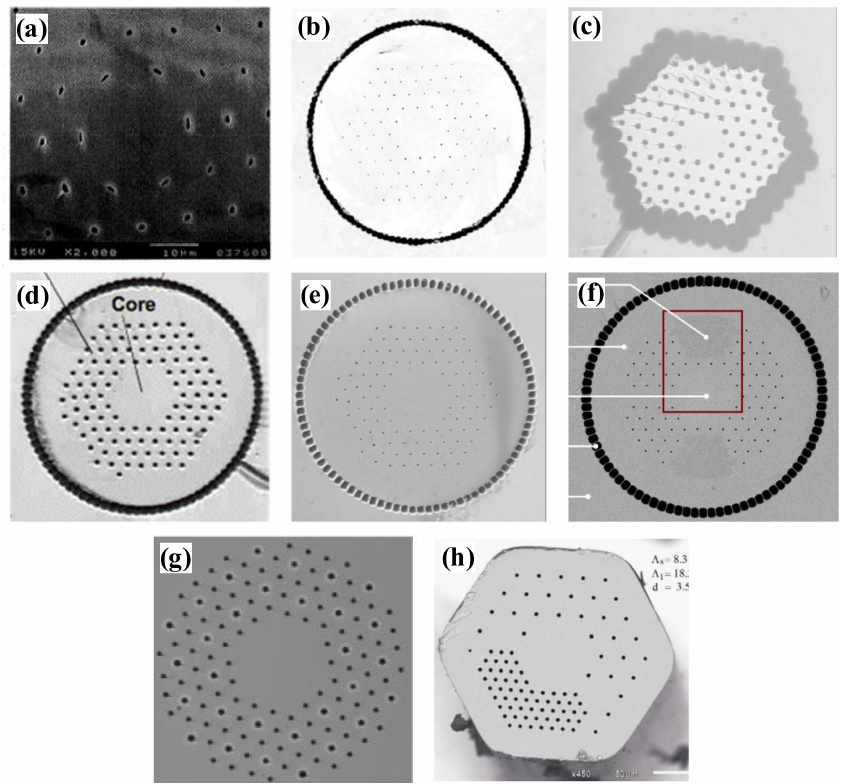
Figure 5. Schematic structure of LMA-PCFs ( a ) 22.5 µ m core diameter developed at Bath Univer- sity [51]; ( b ) 35 µ m mode field diameter rod PCF designed at Jena University [55]; ( c ) Yb-doped PCF with a mode field diameter of 30 µ m developed at Jena University [54]; ( d ) 100 µ m Yb-doped rod PCF developed at the AFRL [67]; ( e ) 50 µ m mode field diameter developed at Jena University [61]; ( f ) 54 µ m mode field diameter reported by Crystal Fiber A/S [62]; ( g ) 59 µ m mode field diameter PCF developed by NKT [64]; ( h ) 42 µ m mode field diameter reported by the University of Brussels [59].